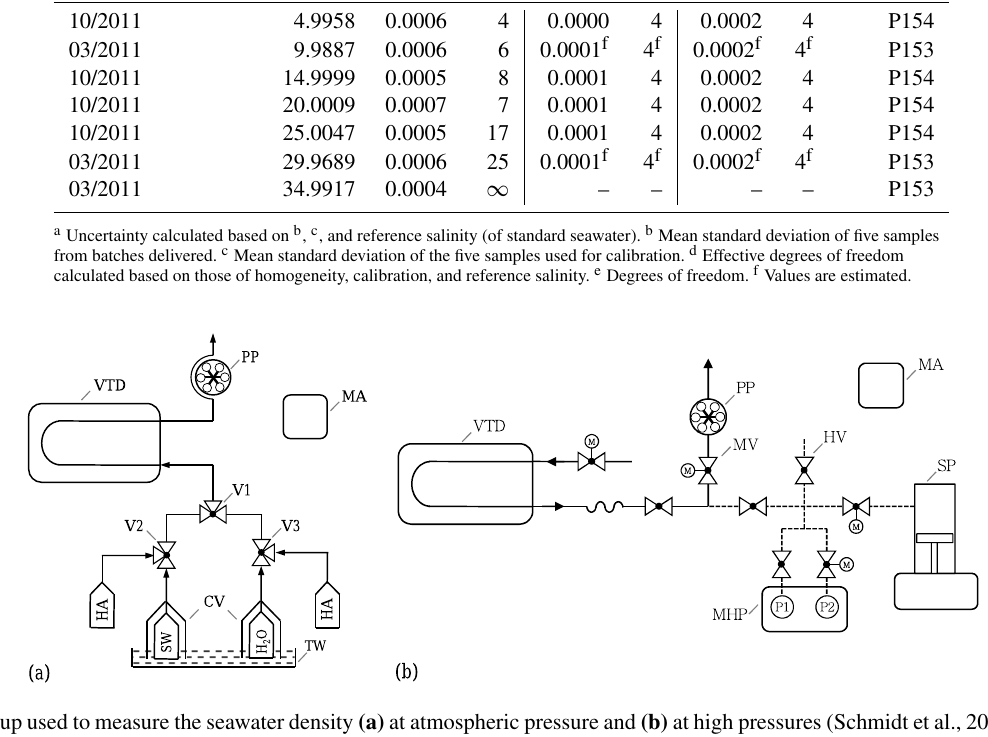
Figure 1. Set-up used to measure the seawater density (a) at atmospheric pressure and (b) at high pressures (Schmidt et al., 2016). The arrows indicate flow direction in capillary tubes. VTD – densimeter, PP – peristaltic pump, V1 – liquid switching valve, V2/V3 – air switching valves, SW – seawater, H 2 O – water, HA – humid air, CV – cover, TW – tap water, MA – manometer for atmospheric pressure, MV – motor-driven valve, HV – manual valve, SP – syringe pump, and MHP – manometer for high pressure (P1 – full-range sensor, P2 – low-range sensor). Dashed lines indicate tubes filled with oil. © Bureau International des Poids et Mesures. Reproduced by permission of IOP Publishing. All rights